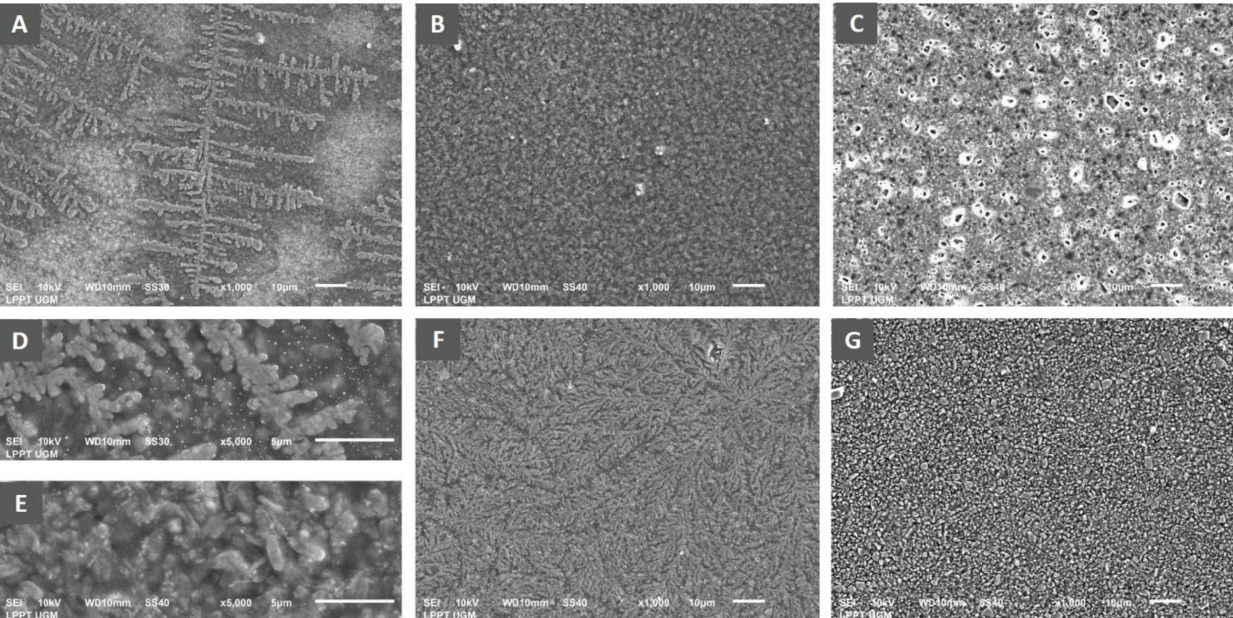
Figure 5. Scanning electron micrograph of P. aeruginosa biofilm showed the formation of specific bacterial colonies on the adhesion surface with extensions indicating bacterial motility in the group exposed to royal jelly 6.25% ( A ), complete coverage of the adhesion surface by the bacterial biofilm mass in the treatment group with royal jelly 12.5% ( B ). Adhesion surface was free from bacterial biofilm in the bacterial group treated with 25% royal jelly ( C ). Figure D shows the biofilm architecture of the 6.25% royal jelly group, and E is that of the 12.5% royal jelly group at a magnification of x5000. The negative control group showed evenly distributed bacterial colonies on the adhesion surface ( F ), while the positive control group (chlorhexidine) showed complete inhibition of biofilm formation ( G ). Overall, the SEM results presented the highest increase in biofilm mass formation by 12.5% royal jelly. ATCC 10145